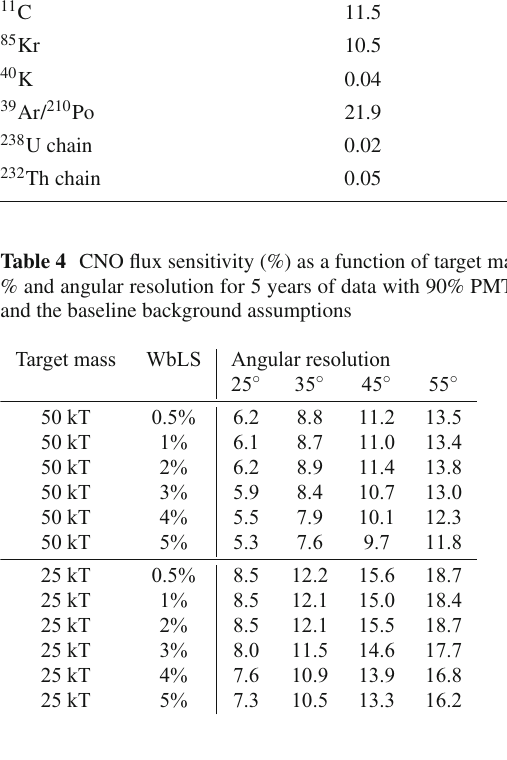
Detector size, target, and angular resolution The CNO solar neutrino sensitivity as a function of detector size, LS fraction, and angular resolution for the baseline background assump- tions is shown in Table 4 and Fig.